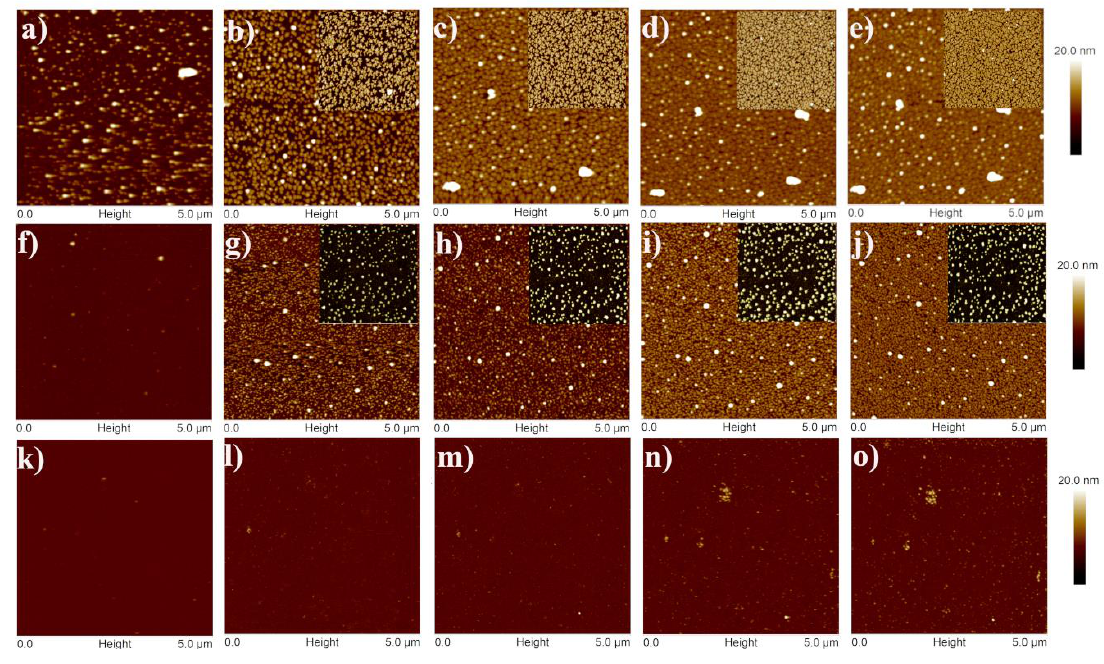
Figure 3. Atomic Force Microscopy height images for the SbpA S-layer formation from ( a – e ) 25 µg/mL, ( f – j ) 10 µg/mL, and ( k – o ) 5 µg/mL solutions in continuous flow conditions. The sequence reflects (left to right) the film topography observed after 15, 30, 60, 120, and 180 min since SbpA injection begins. Insets show the corresponding image (same time-lapse and measuring scales) when operating under stopped-flow